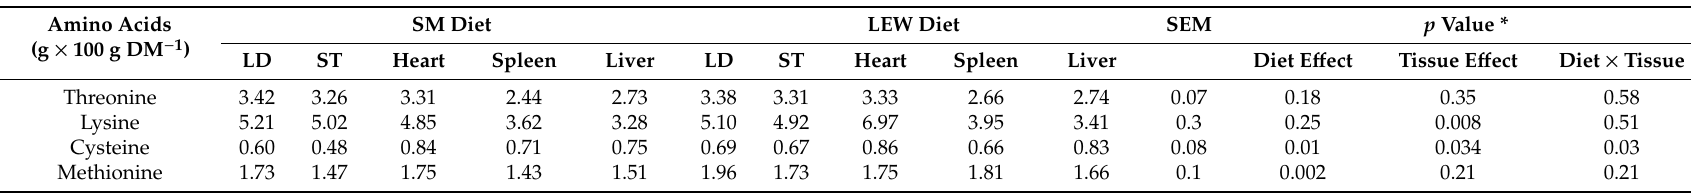
Table 7. E ff ect of dietary extruded linseed:walnut meal 50:50 ( wt / wt ) mix on amino acid concentration in di ff erent tissues (longissimus dorsi (LD) and semitendinosus (ST) muscles, heart, spleen, liver,